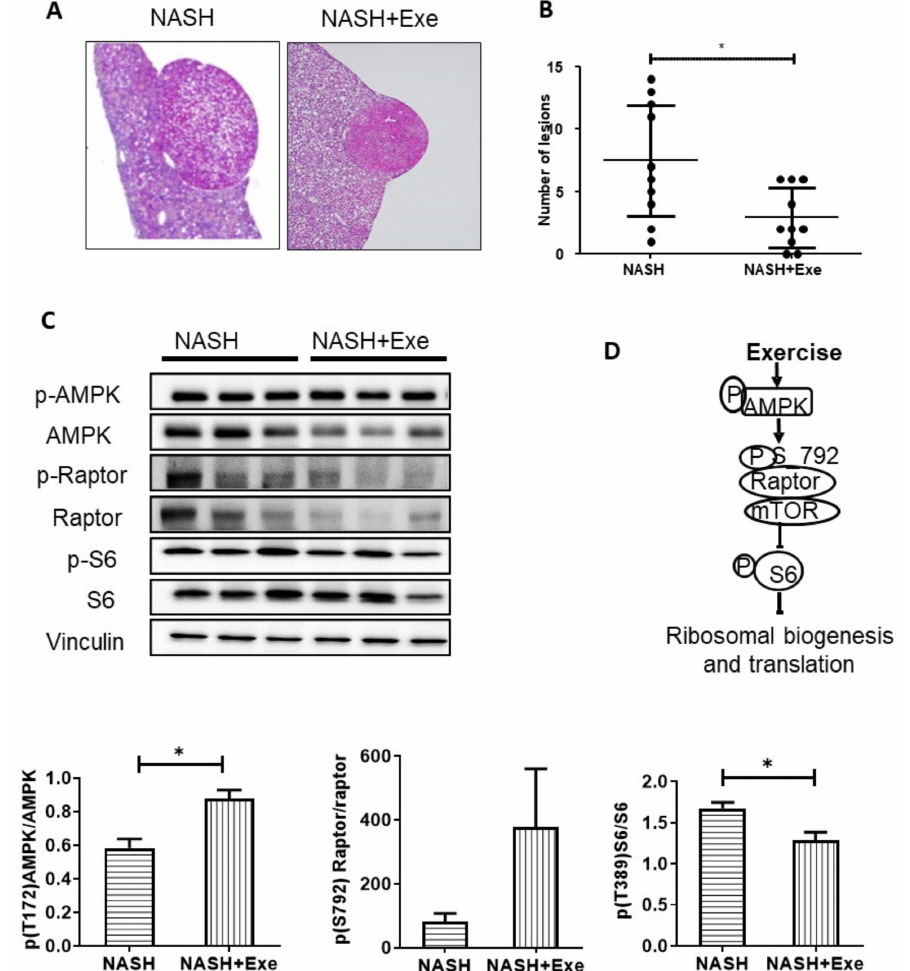
Figure 9. E ff ect of exercise on liver tumors. ( A ) Representative histological images of hematoxylin and eosin (H&E)-stained liver sections with adenomas in NASH sedentary (left panel) and exercise (right panel) mice (magnification x40). ( B ). Comparison of the number of liver adenomas in NASH sedentary and NASH + EXE mice. NASH + EXE mice developed fewer nodules than did NASH sedentary mice (Mann–Whitney U-test; * p < 0.05). ( C ). Immunoblots showing protein expression and phosphorylation status of AMP-activated protein kinase (AMPK), regulated associated protein of mTOR (Raptor) and ribosomal protein S6. Signals were quantified and normalized for vinculin. Phosphorylation of AMPK was increased and phosphorylation of S6 was decreased in the NASH-EXE group. Groups are as described in Figure 1 (unpaired t -test; p < 0.05). For more details of Western